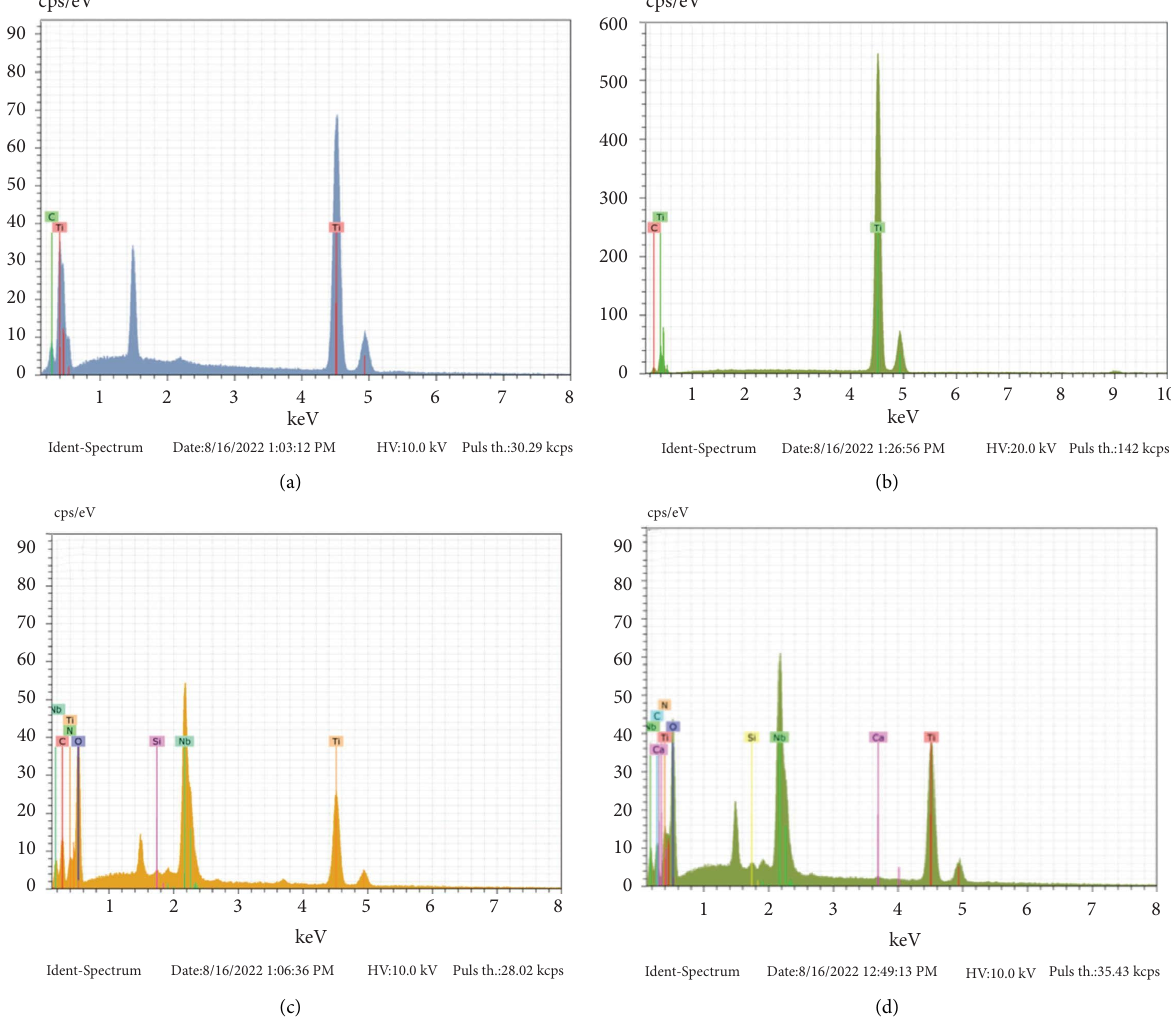
Figure 2: EDS spectra of chemical composition analysis of Ti surface before and after graphene oxide and niobium pentoxide coating. (a) cp Ti before coating. (b) cp Ti-GO. (c) cp Ti-NB. (d) cp